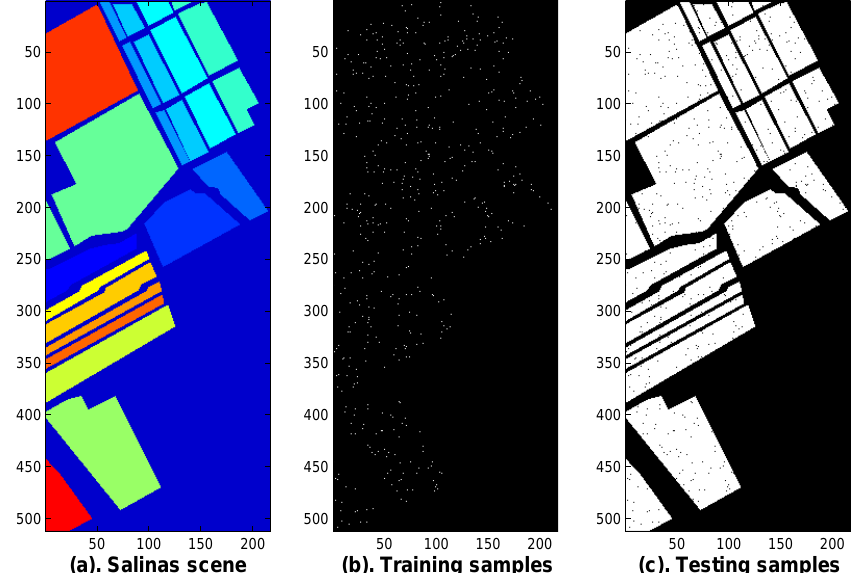
Figure 13. Illustration of AVIRIS Salinas dataset: ( a ) ground truth; ( b ) distribution of training samples; ( c ) distribution of testing